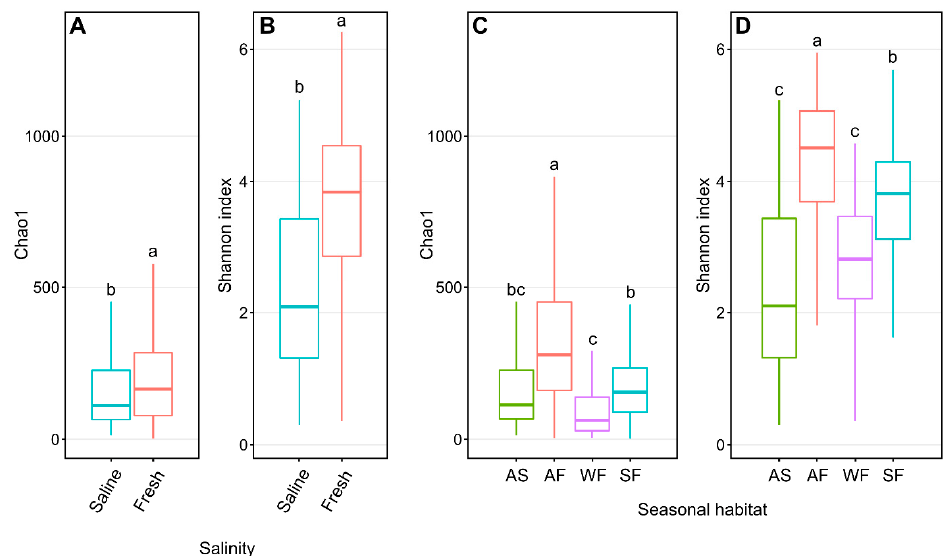
Figure 2. Alpha diversity metrics of Chao1 and Shannon entropy assessments of Arctic char skin community richness and diversity, respectively. Plots show differences between samples obtained from saline water (S; n = 124) and freshwater (F; n = 317) ( A , B ) and different seasonal habitats ( C , D ) including samples obtained from autumn saline water (AS; n = 124), autumn fresh water (AF; n = 106), winter fresh water (WF; n = 63), and spring fresh water (SF; n = 148). Different lower-case letters within the graphs display significantly different ( p < 0.001) groupings as determined by one-way ANOVA.